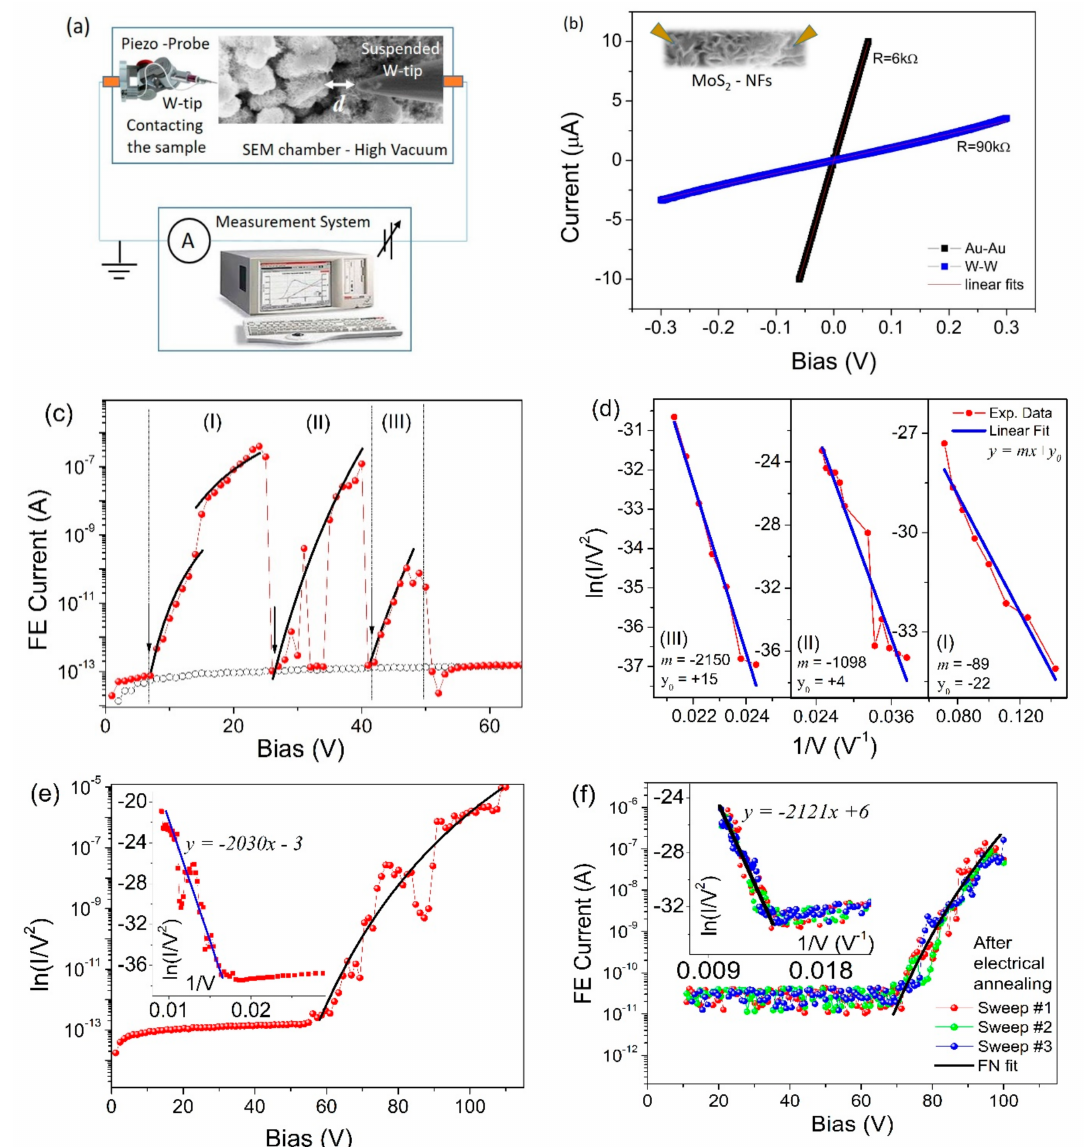
Figure 3. ( a ) Schematic of the FE measurement setup; ( b ) I-V characteristics measured by contacting both electrodes on the sample surface; ( c ) FE curve measured as first voltage sweep in a virgin area of the sample. Three successive regions of emission are identified. Black arrows indicate the turn-on voltage for each region. Black empty circles are experimental data measured in open circuit configuration. Black solid lines are the numerical simulations according to FN-theory (Equation (1)); ( d ) FN-plots for the di ff erent regions. Solid lines are the linear fittings; ( e ) FE curve measured in a di ff erent location after the initial electrical stress; ( f ) Three consecutive voltage sweeps measured in a third di ff erent location always after electrical stress to show the FE